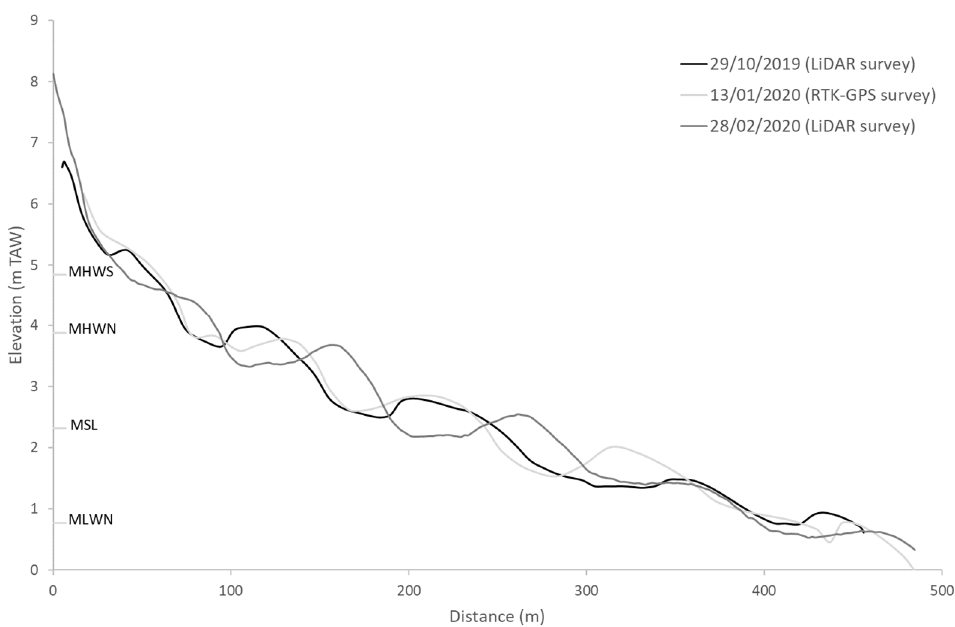
Figure 8. Cross-shore profiles starting from the upper-beach of the pre- and immediately after storm.